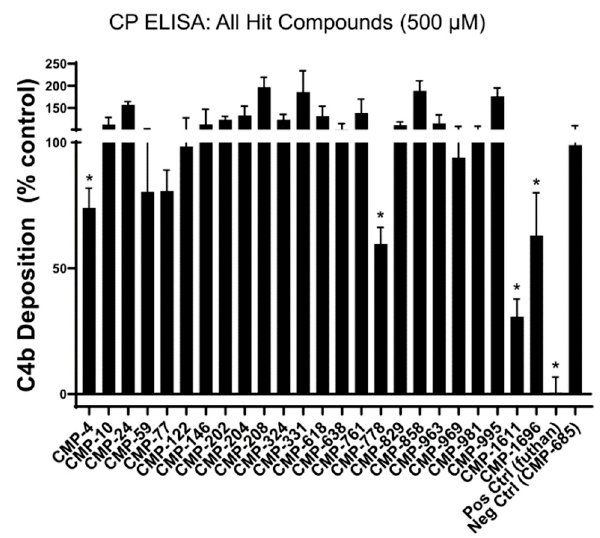
Figure 4. Inhibition of the classical pathway by selected hit compounds. All 24 hit fragments were tested for their ability to block C4 activation in an ELISA-based assay under conditions specific for the classical pathway. Each compound was tested in triplicate at a single concentration of 500 µ M. Positive hits (four in total) were defined as any compound that significantly reduced C4b deposition relative to a non-binding control compound (CMP-685), as judged by an unpaired t -test (* p < 0.05).